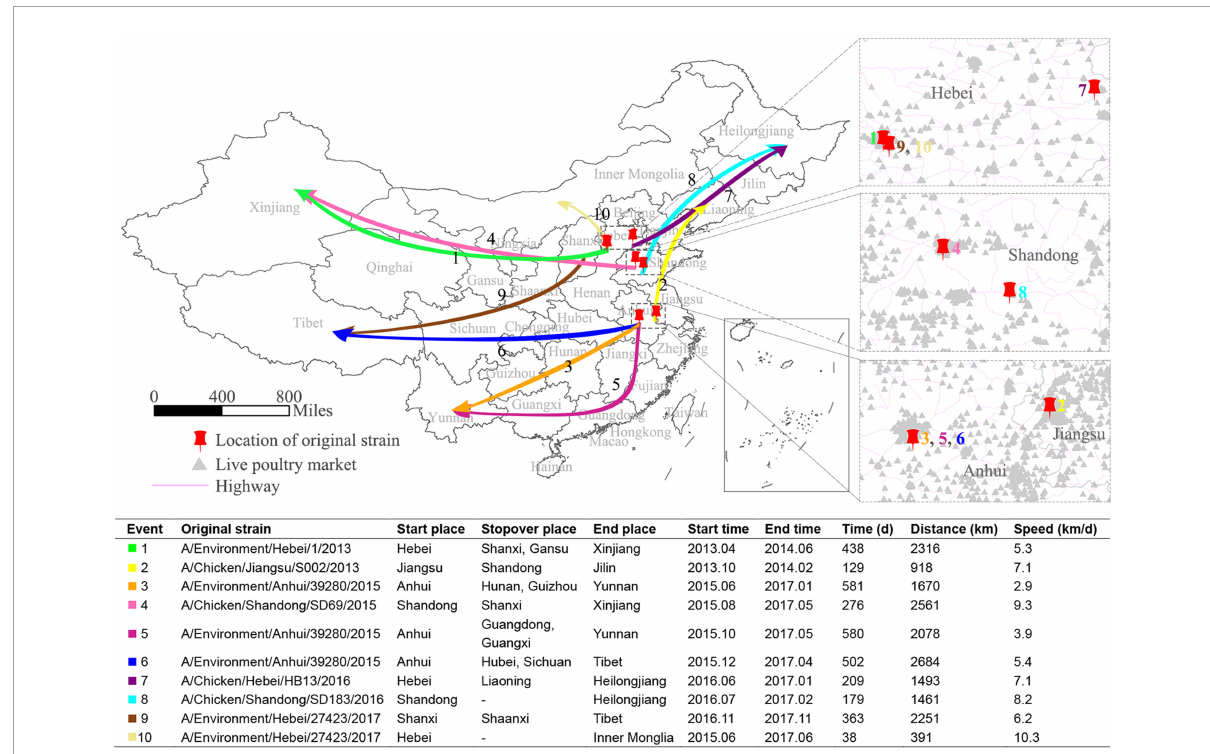
FIGURE6 Diffusion of the H7N9 viruses over long distance. Ten long-distance spread routes of the H7N9 viruses are showed as colored arrows on the map of China. The enlarged maps display the starting places for these 10 routes, with red pushpins marking the location of the starting sites, violet lines representing highways, and light gray triangles showing the location of live bird markets. The table shows the statistics of the 10 long-distance spread